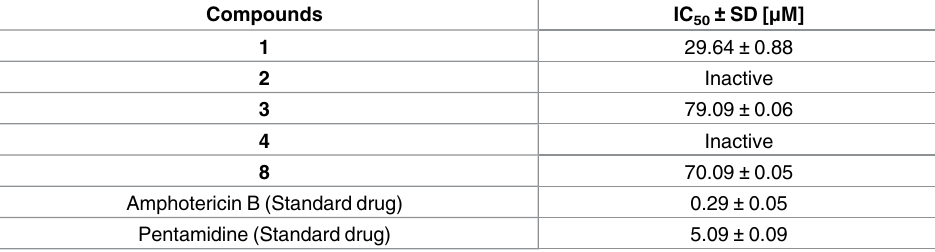
Table 4. Leishmanicidal activity of mibolerone (1), and its